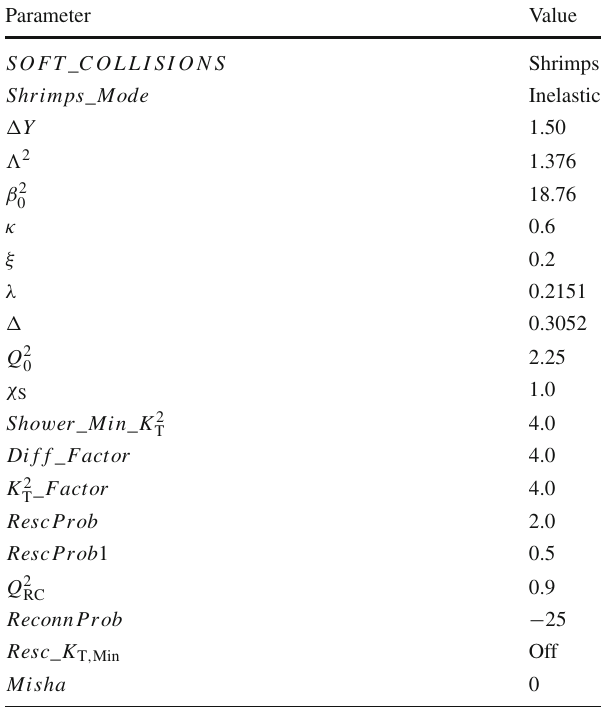
Table 2 Parameters of the Sherpa 2.2.2 model for the production